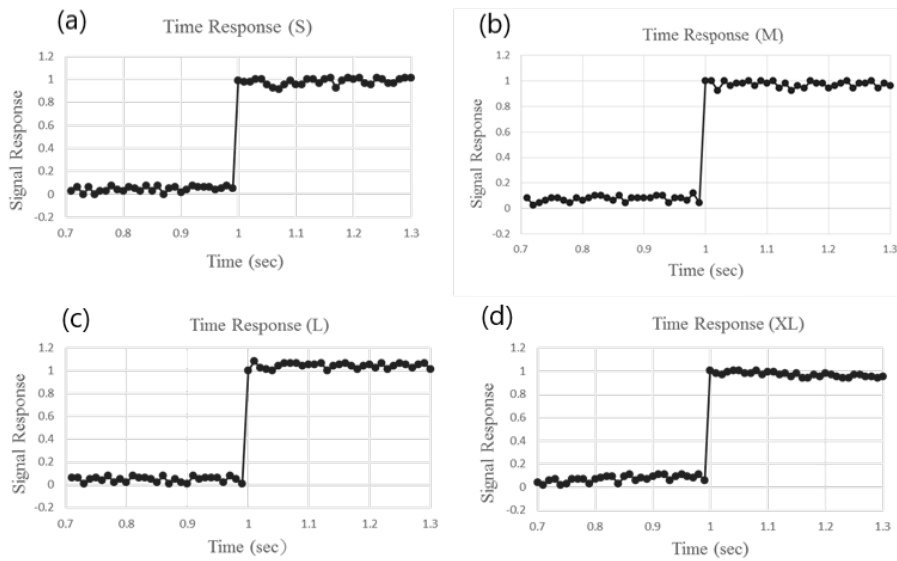
Figure 10. Time responses of Hall sensors of various sizes: ( a ) S, ( b ) M, ( c ) L, and ( d ) XL.